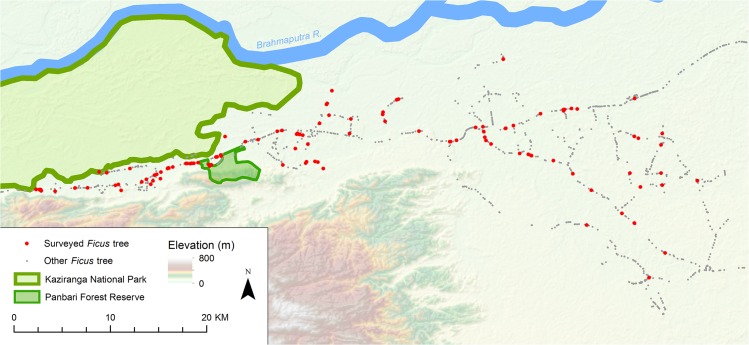
Locations of the 1,857 Ficus trees marked in the study area.Red circles denote surveyed trees, grey circles denote trees that were not surveyed. The linear pattern at this scale indicates the association between roads and the distribution of Ficus trees. Kaziranga National Park and Panbari Forest Reserve contain the only relatively intact forests in the study area.